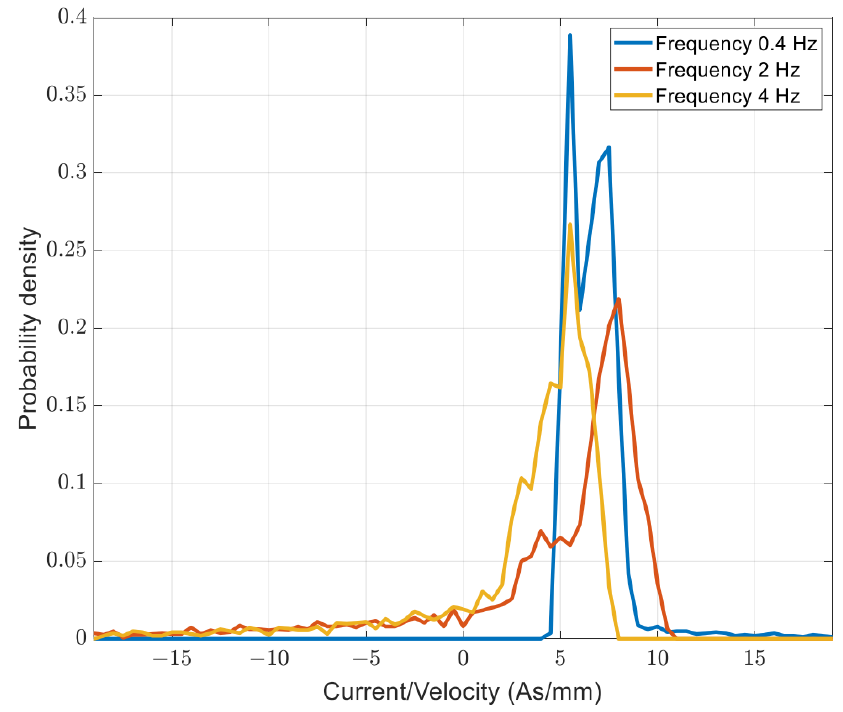
Figure 9. Probability density distribution of the ratio of streaming electrification current to velocity. The distribution has a median in the range from 4.5 to 6.7